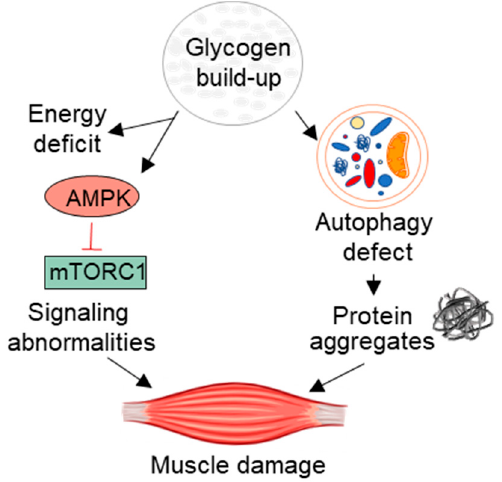
Figure 1. Pathogenic cascade of muscle damage in Pompe disease.